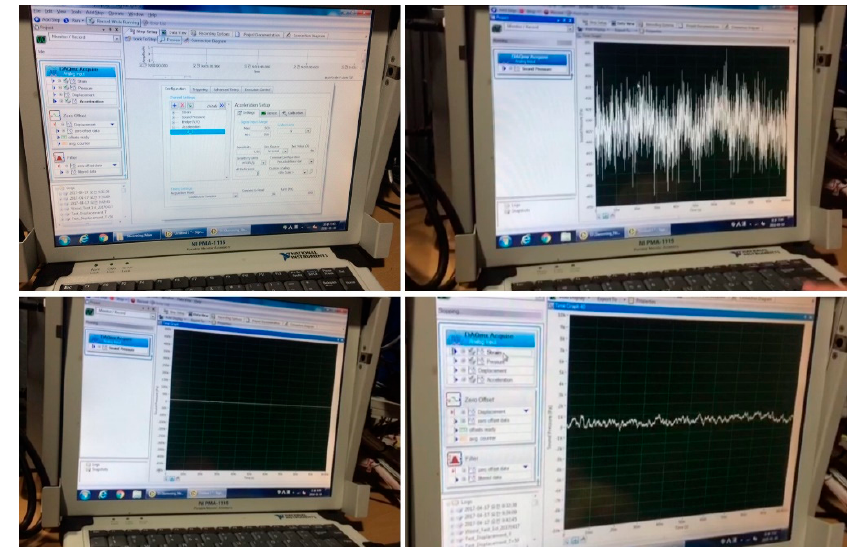
Figure 6. Sensors calibration and data measuring rate set before free drop test.